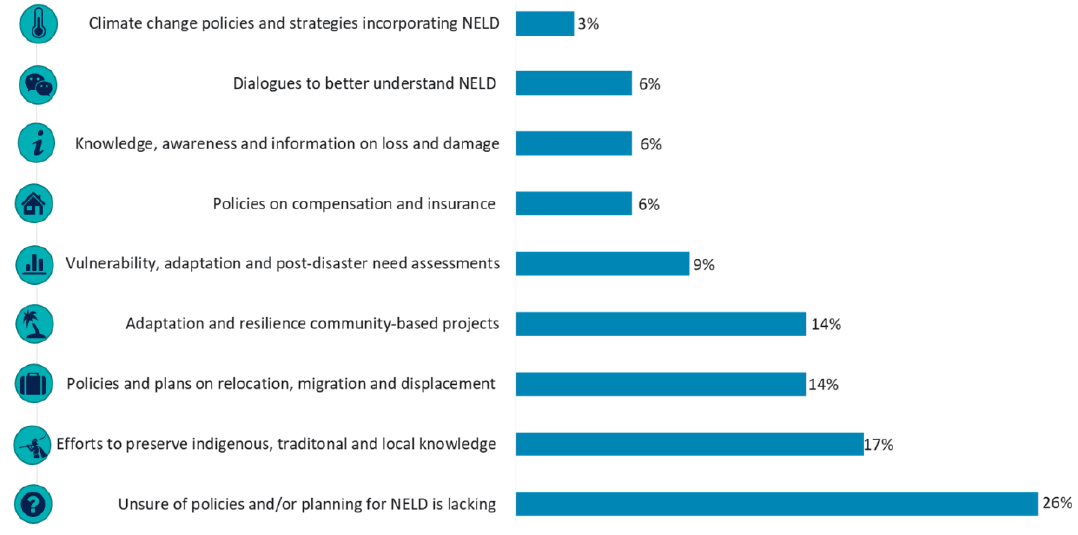
Figure 2. Current policy responses to plan for and address NELD in the Pacific Islands with the percentage of participants who highlighted each response.